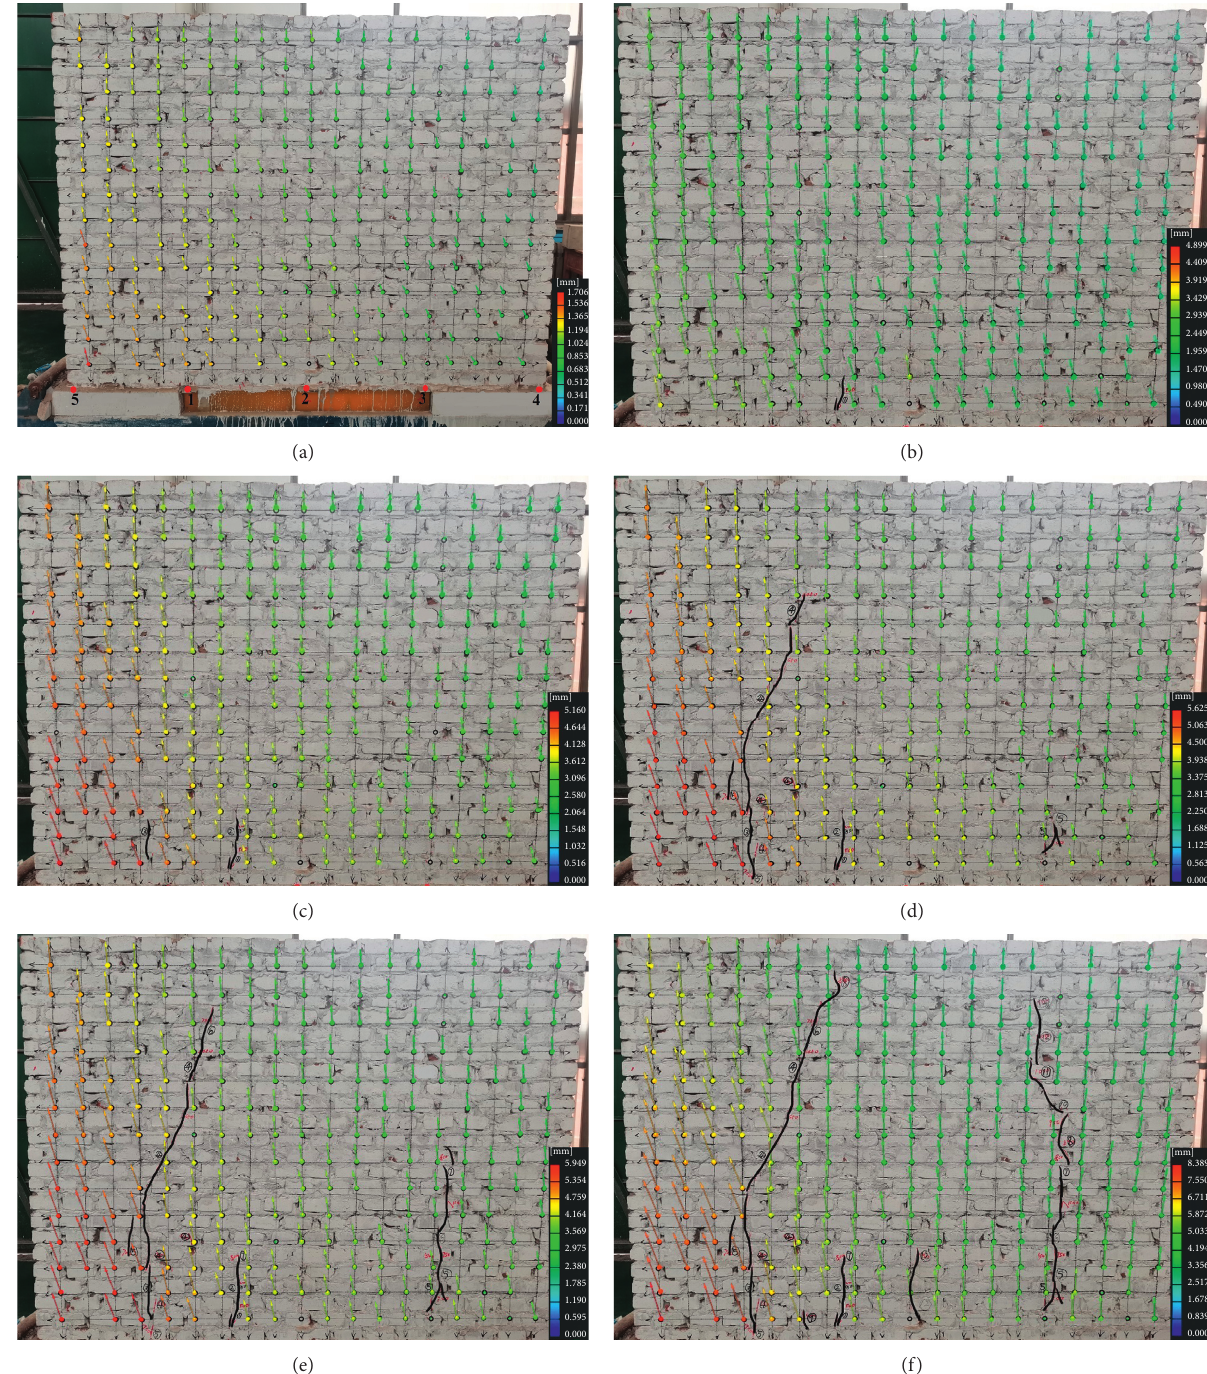
Figure 14: Noncoding point displacement nephogram under different pressures. (a) 0.2MPa. (b) 1.04MPa. (c) 1.25MPa. (d) 1.45MPa. (e) 1.87MPa. (f)